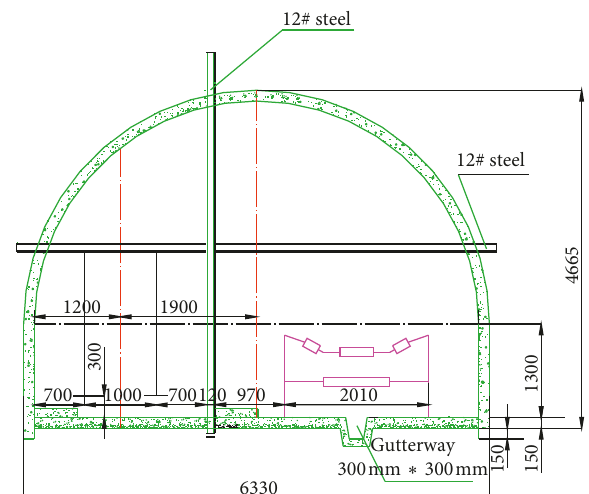
Figure 1: Cross section of the roadway.